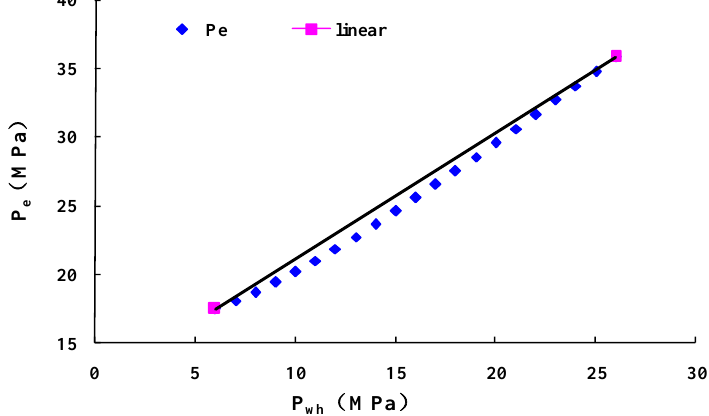
Figure 2—Relationship of Casing Pressure Reservoir